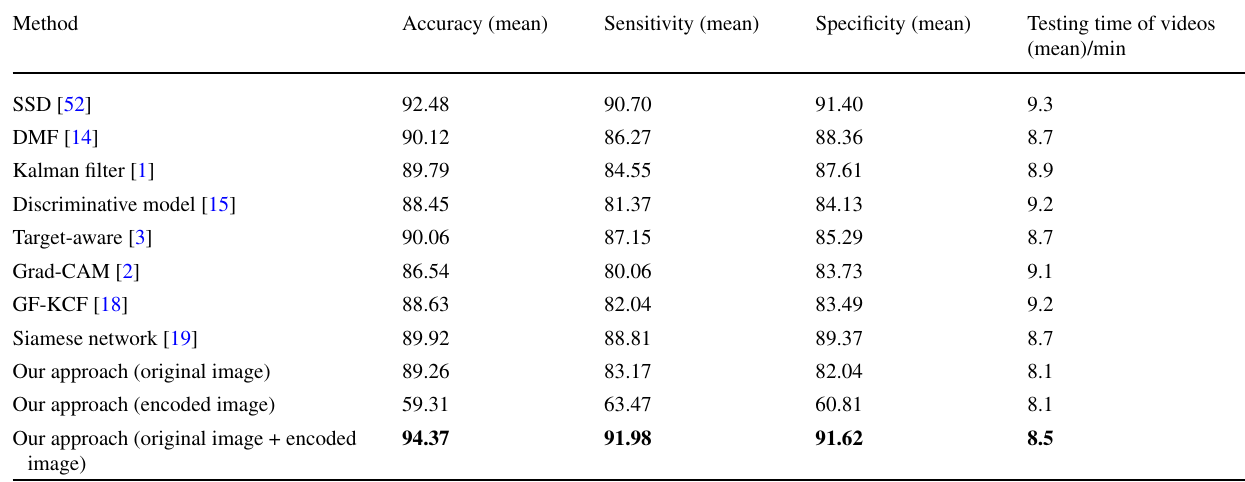
Table 1 Comparison between our pipeline and other baseline models on the Dim-small target detection and tracking dataset Method